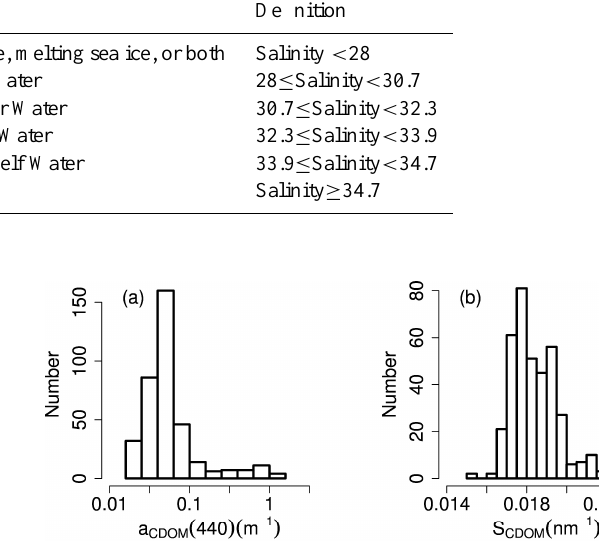
Fig. 4. Histograms of (a) the absorption coefficients of CDOM at 440nm, a CDOM (440) and (b) the spectral slope, S CDOM